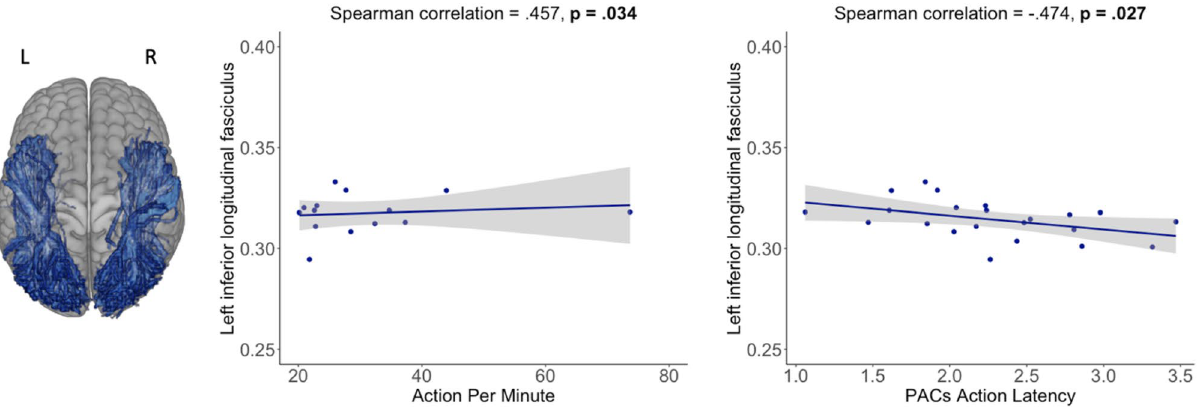
Figure 6. ROIs regions of interest, L left, R right. Predefined ROIs (left inferior longitudinal fasciculus) and scatter plots representing the significant association between FA values along the left inferior longitudinal fasciculus and StarCraft II skill acquisition indicators. The results presented in the figure are without the FDR